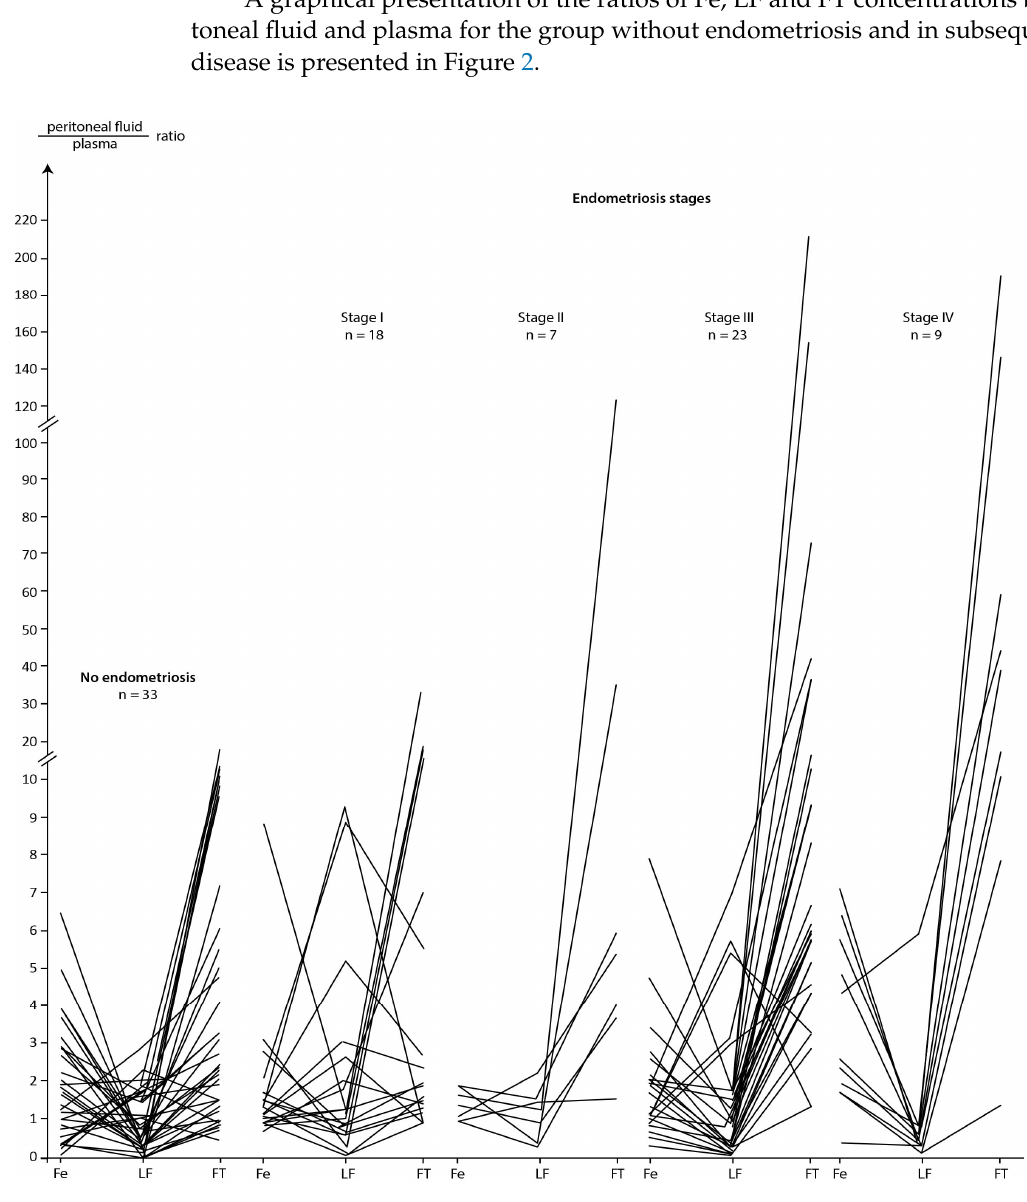
Figure 2. Peritoneal fluid/plasma ratios between Fe, LF, and FT in group without and subsequent stages of endometriosis.